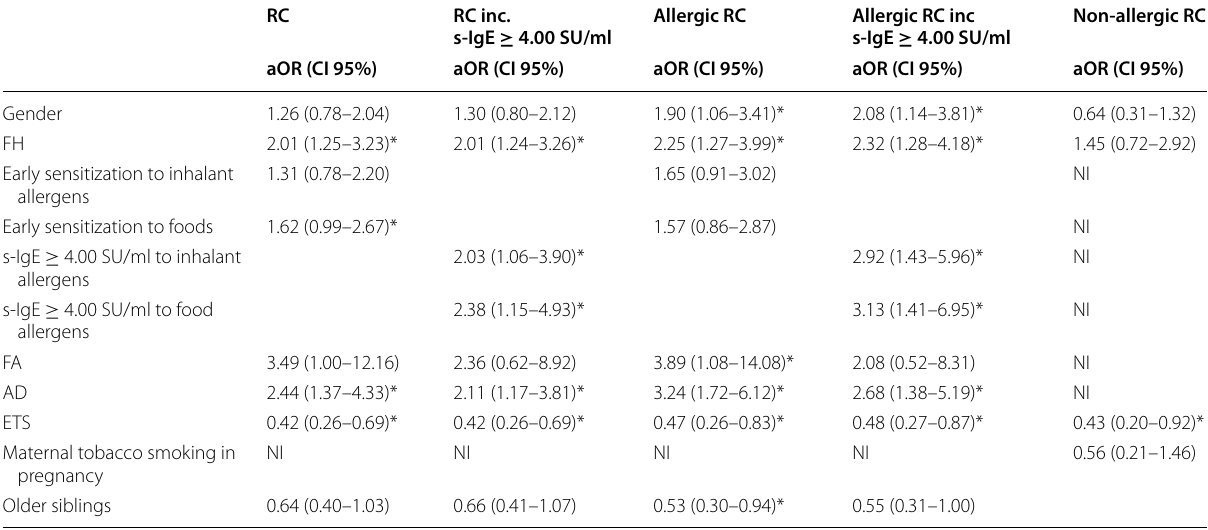
Table 4 Adjusted effect estimates (aOR CI 95%) for associations with RC, allergic RC and non-allergic RC at 14 years of